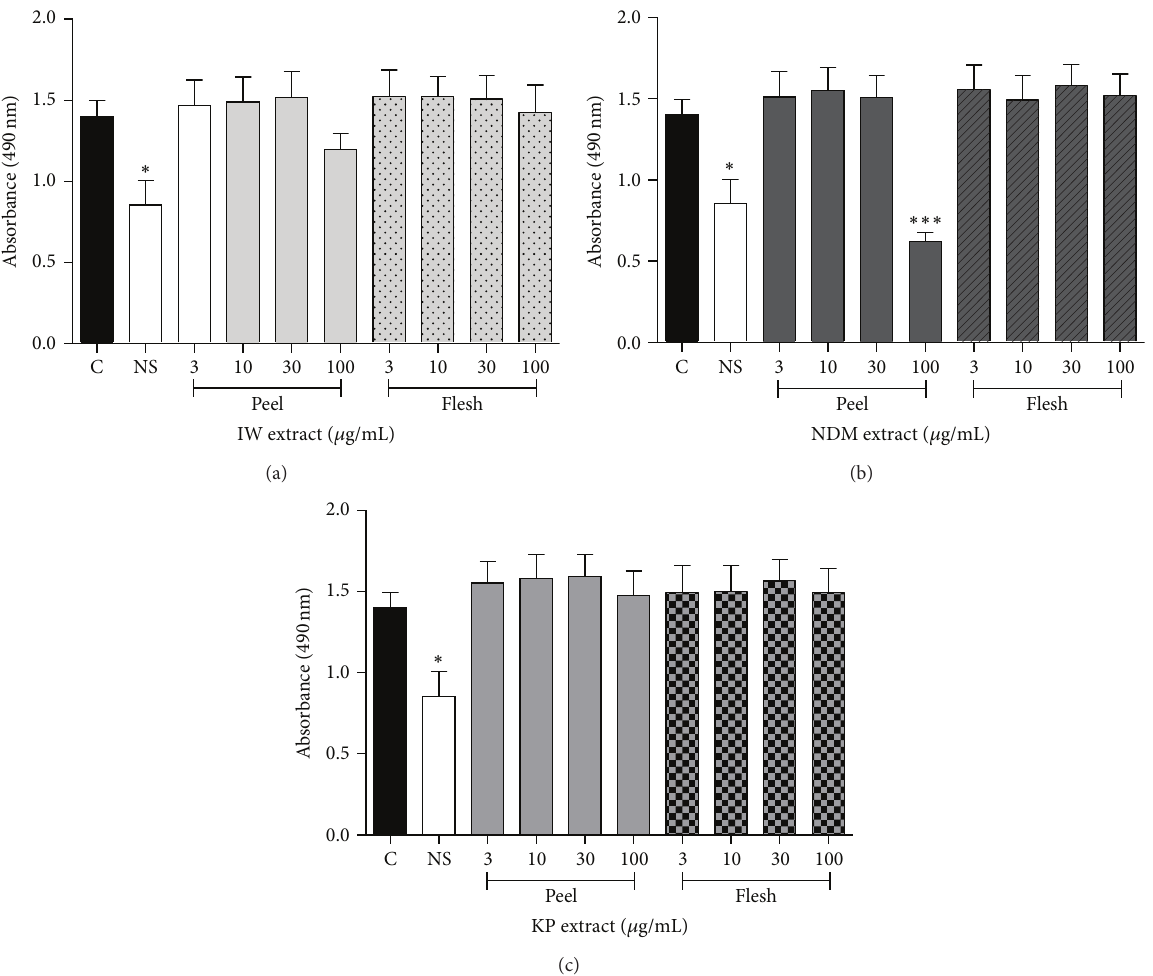
Figure 1: MCF-7 cell proliferation. Breast cell line MCF-7 was treated with increasing concentrations of IW (a), NDM (b), and KP (c) peel and flesh extracts for 96 h. Proliferation was determined by Cell Titer 96 AQ UEOUS One Cell Proliferation Assay. Columns, mean; bars, SE. ∗ 𝑃 ≤ 0.05 versus control (C) ( 𝑛 ≥ 9 ). ∗∗ 𝑃 ≤ 0.01 . ∗∗∗ 𝑃 ≤ 0.001 no serum